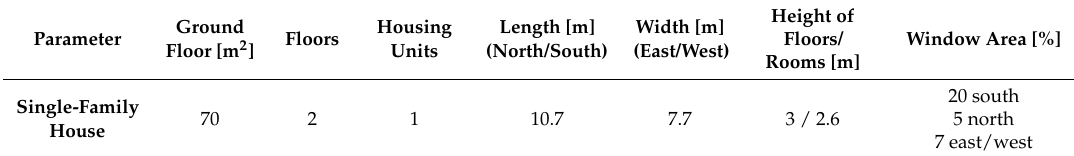
Table 2. Exemplary parameters of the category single-family